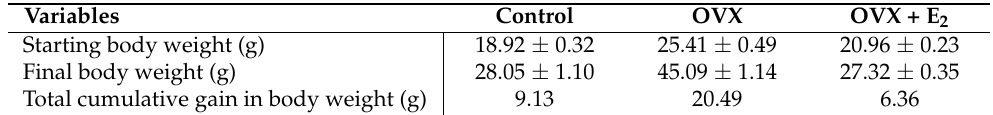
Table 3. Data is expressed as mean ± SE. Differences in starting body weight, final body weight, and the total cumulative gain in weight in each of the experimental groups are presented ( n = 6). Variables Control OVX Starting body weight (g) Final body weight (g) Total cumulative gain in body weight